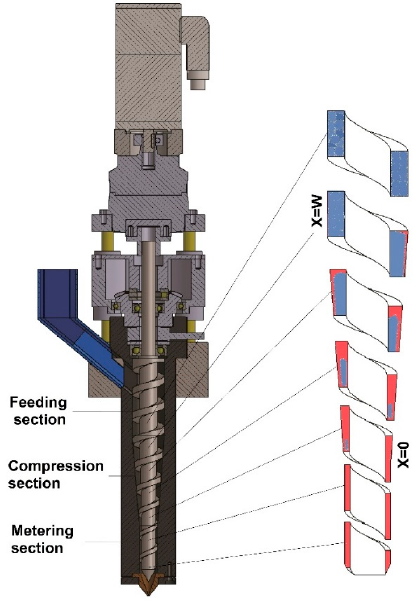
Figure 2. Polymer melting in the consecutive cross-sections of a micro-extruder; settings in Table 1 (Column 2). The right-hand side illustrates the concept of melt removal by drag. Blue, solid; red, molten. Melting is done once the solid bed width ( X ) vanishes.